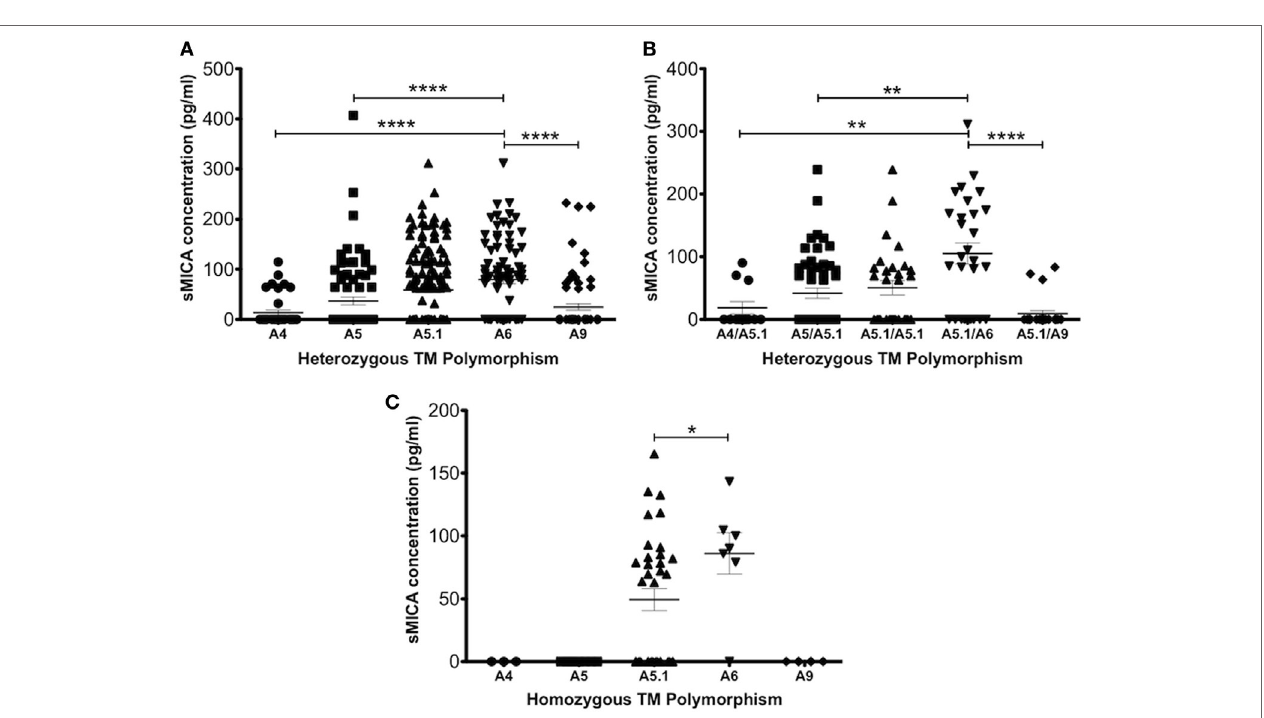
FigUre 6 | Influence of MHC class I-related chain A (MICA) transmembrane (TM) polymorphism on sMICA levels detected in umbilical cord blood (UCB) plasma samples. UCB samples were stratified according to the number of alanine residues encoded by GCT triplet (Ala) repeats in exon 5 of the MICA gene. (a) Heterozygous allele combinations with any other allele. (B) Heterozygous allele combinations with A5.1, which associates with MICA*008 with high frequency. (c) Homozygous TM polymorphism. Data represent MICA typing and ELISA measurement of sMICA obtained from 181 cord blood samples. Statistical analysis was performed using Kruskal–Wallis test with Dunn’s post hoc test ± SEM (* P ≤ 0.05, ** P < 0.01, and **** P < 0.0001).